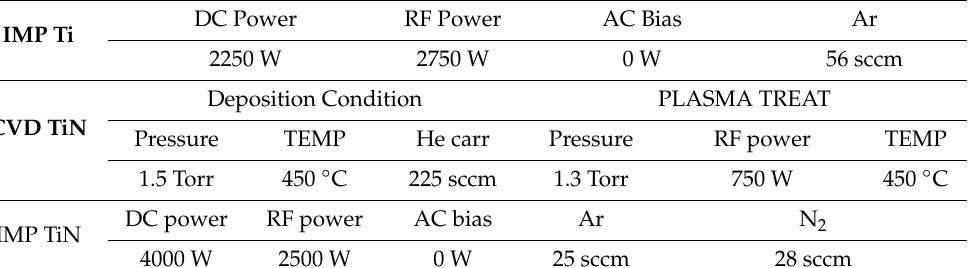
Table 2. Deposition conditions for each film.